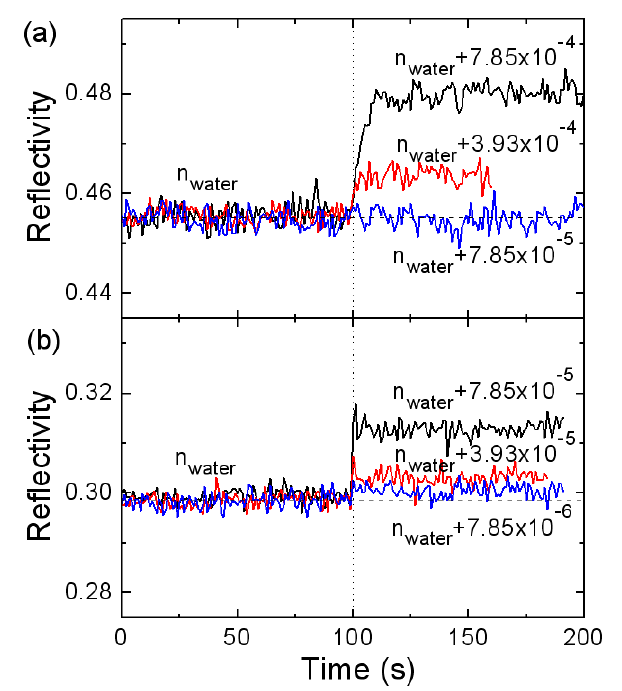
Figure 6. Temporal responses of the SPR reflectivity measured before and after injection of dilute sucrose solutions at the angle of highest slope of SPR dip curves for (a) conventional SPR and (b) Bi-WCSPR2